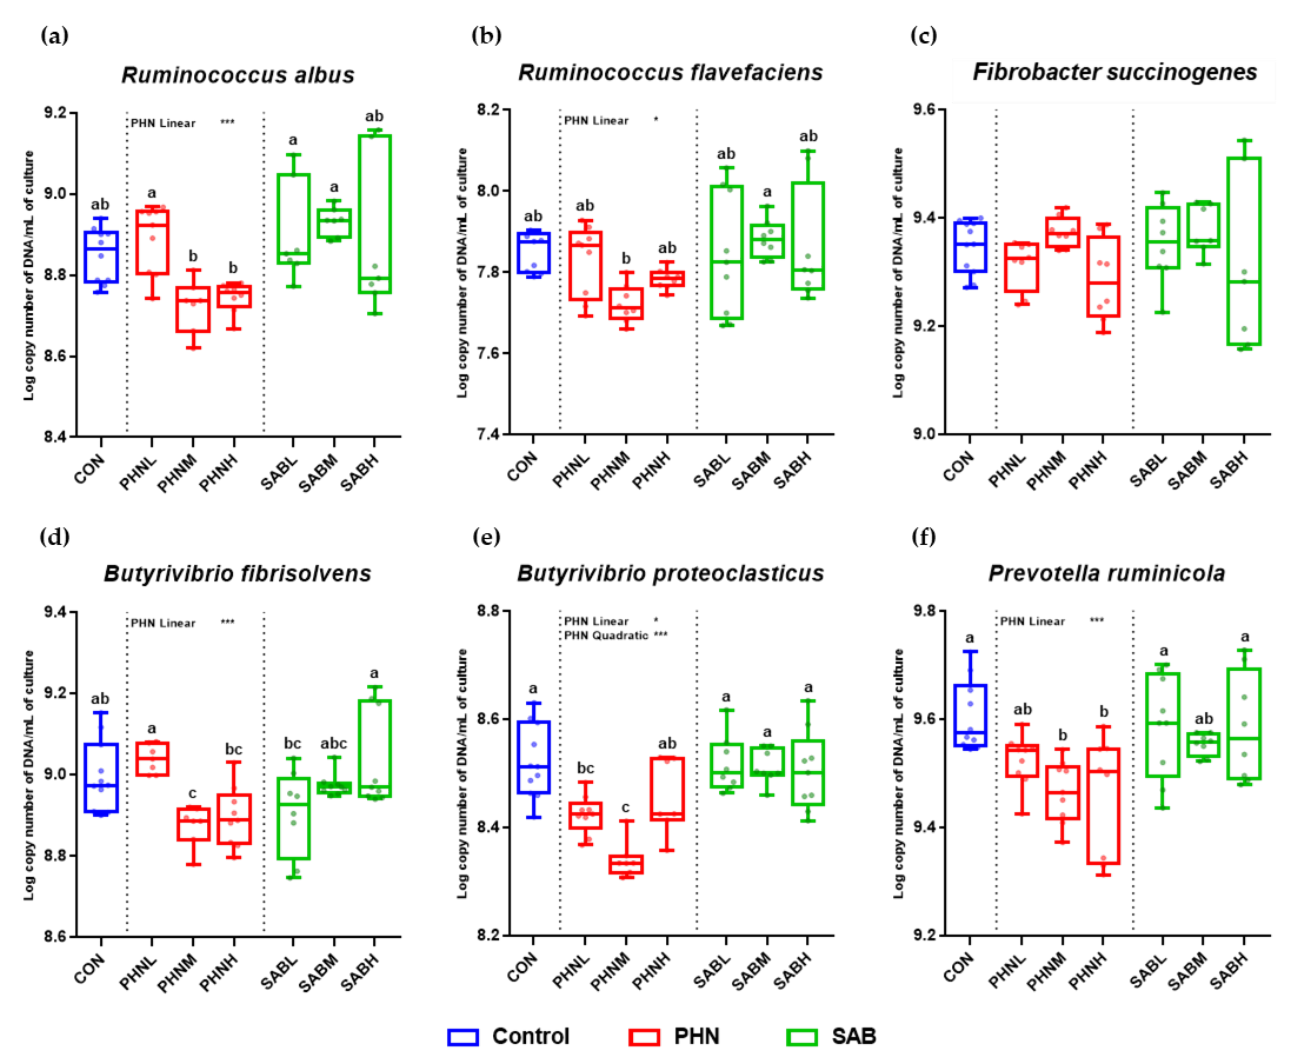
Figure 2. Effects of bamboo leaves addition on the population of Ruminococcus albus ( a ), flavefaciens ( b ), Fibrobacter succinogenes ( c ), Butyrivibrio fibrisolvens ( d ), proteoclasticus ( e ), and Prevotella ruminicola ( f ) (Log copy number of DNA/mL of culture) at 48 h incubation time. Error bars are standard error of the mean ( n = 4). abc Means with different superscripts in the same row indicate significant differ- ences ( p < 0.05). Orthogonal contrasts for linear and quadratic effects were considered statistically significant at * p < 0.050 and *** p < 0.001.